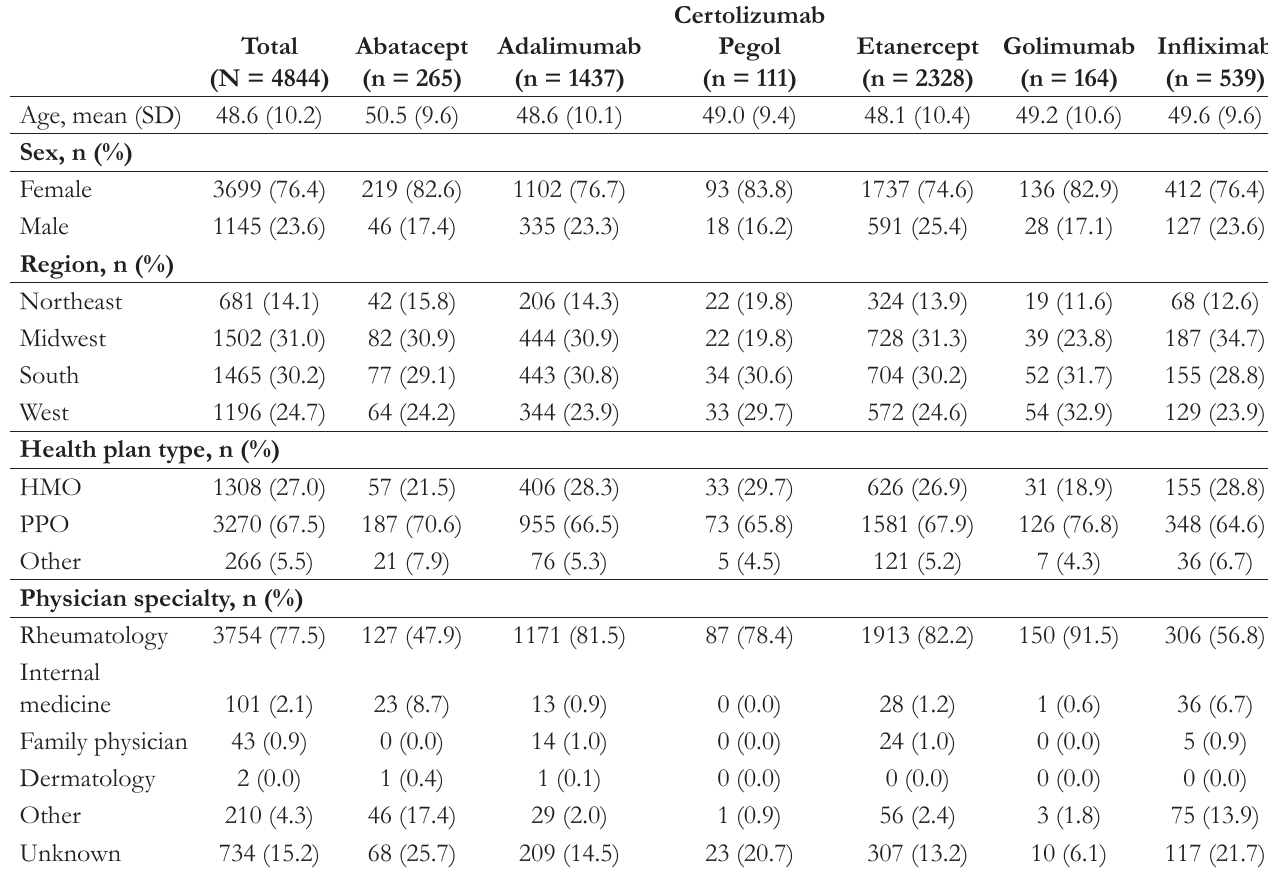
Table 2. Characteristics of the Study Population